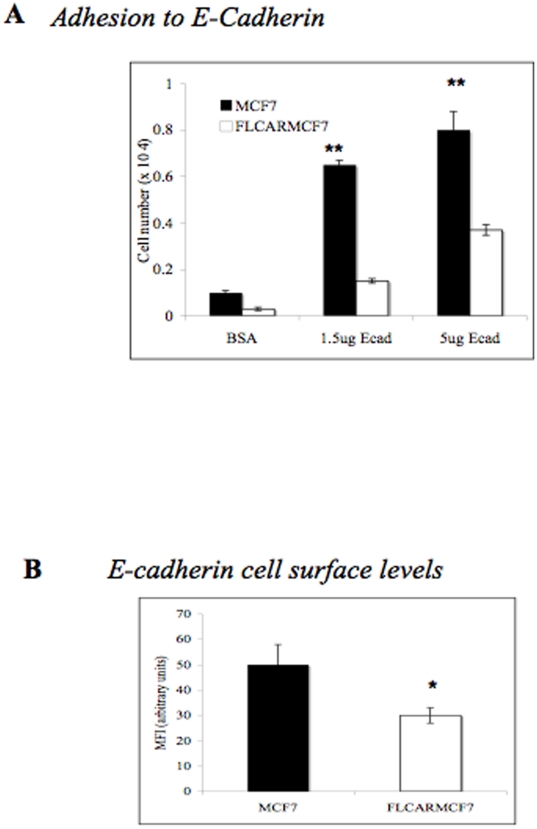
CAR overexpression reduces E-cadherin cell adhesion and E-cadherin cell surface levels.(A) E-cadherin extracellular domain was immobilised onto 24-well plates at 1.5 µg/ml or 5 µg/ml. BSA was used as a control. MCF7 (black bars) or FLCARMCF7 cells (white bars) were seeded at 5×104/well, left for 2 hours, and adherent cells counted. Error bars depict SEM (n = 4). ** p<0.01. (B) FACS analysis of E-cadherin cell-surface expression on MCF7 (black bar) and FLCARMCF7 cells (white bar). MFI per cell pooled from 4 independent experiments is shown +/−SEM. * P<0.05. Significance was determined by a two-way anova.